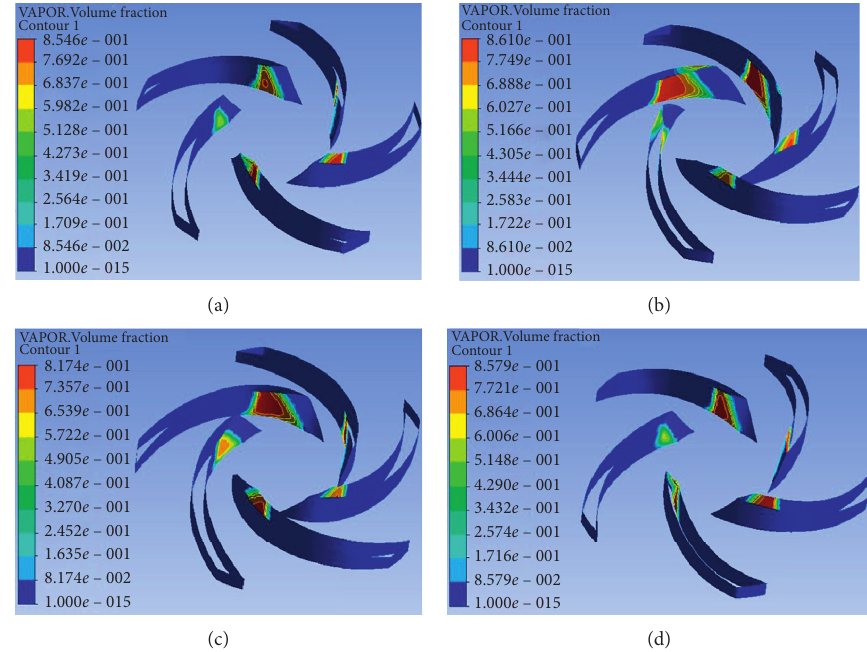
� 1m). (a) Single arc. (b) Double arc. (c) Logarithmic spiral. (d) B-spline curve. r